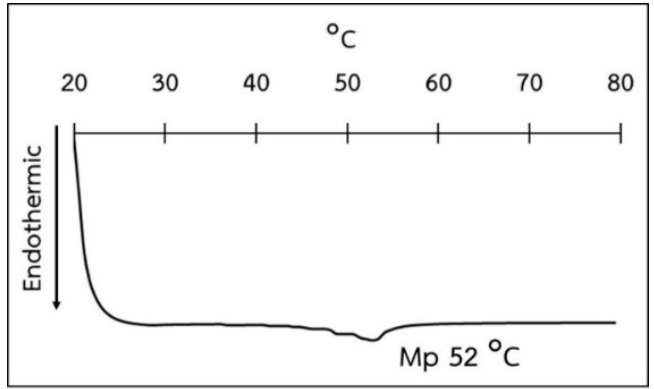
Figure 7. DSC thermogram of NLC-C.